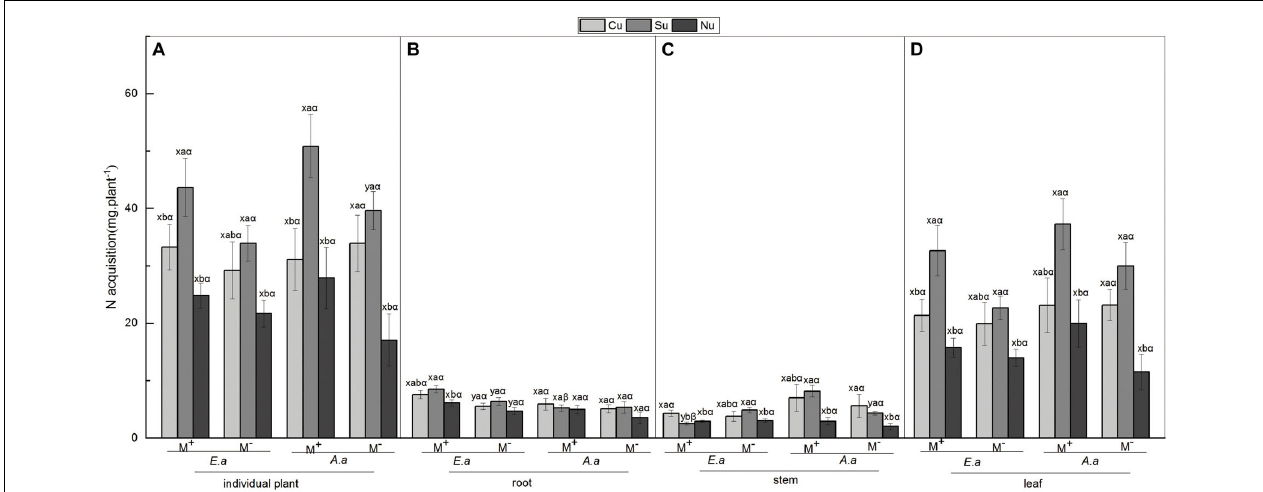
FIGURE 3 | N acquisition of E. adenophorum and A. annua seedlings and its allocation to root, stem and leaf. Abbreviations: E. a and A. a ; M + and M − ; Cu and Su and Nu, meaning same as in Figure 2 . The lowercase letters x and y, (a, b, c). The Greek letters α and β above the bars, they mean the same as in Figure 2 . TABLE 4 | Two-Way ANOVAs for the effects of mycorrhizal fungus (M + vs M − ) and nutrient utilization treatments (Cu vs Su vs Nu) on P acquisition of the invasive plant Eupatorium adenophorum and the native plant Artemisia annua . Plant species Factors df P acquisition Root Stem Leaf Individual plant